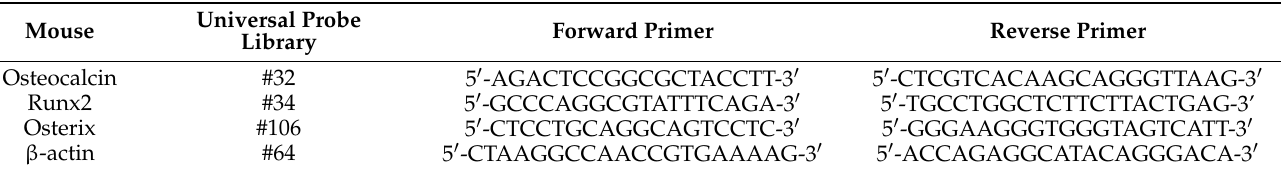
Table 2. Oligonucleotide primers used for quantitative real-time PCR. Mouse